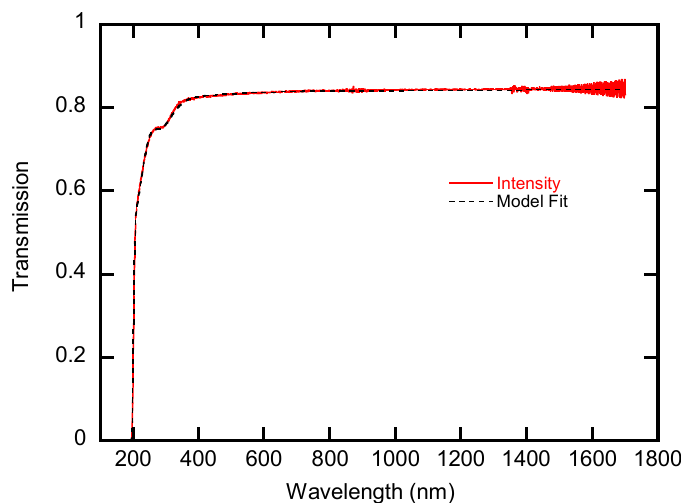
in the previous section. In this analysis, the dielectric function was modeled by a uniaxial-anisotropic material with three Gaussian oscillators for each direction, using the Gen-Osc function by CompleteEase program. Note that the program proves the Kramers–Kronig consistency. The fitting results for SE Ψ , ∆ , and transmission were shown in Figure 11a,b and Figure 12, respectively.